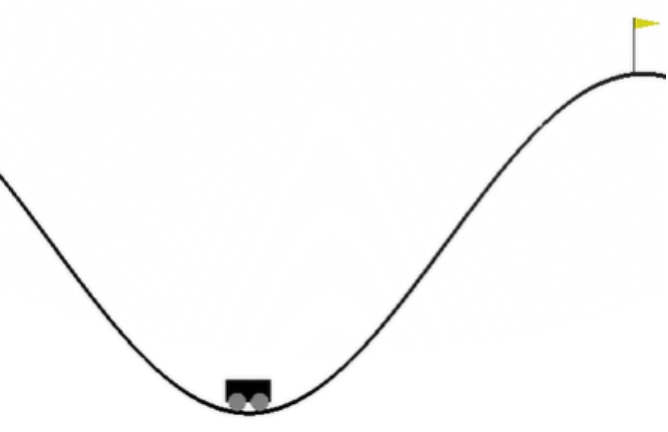
Figure 13. Rendering of the Mountaincar environment.